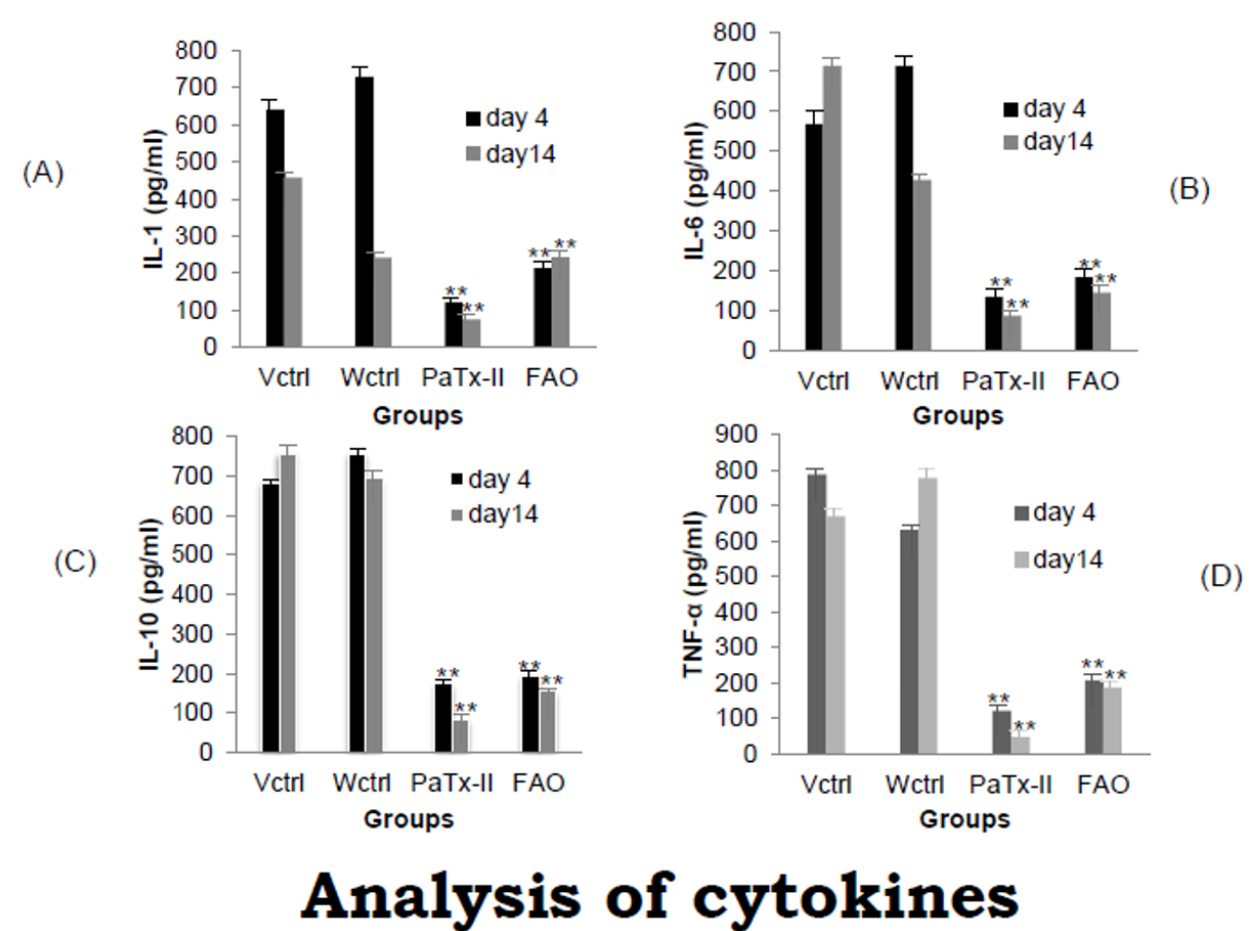
Figure 8. Proinflammatory cytokines were analyzed by an ELISA assay before and after wound treatment in mice. ( A – D ) There were increased levels of the cytokines IL-1, IL-6, IL-10 and TNF- α in untreated, infected wound-control mice, whereas both PaTx and FAO-treated mice show significantly decreased levels of all 4 cytokines after 4 and 14 days of treatment. For treated wounds, the PaTx-II-treated mice show a greater reduction of inflammatory cytokines after 4 and 14 days of treatment compared to the 2% FAO-treated mice. ** p < 0.01.